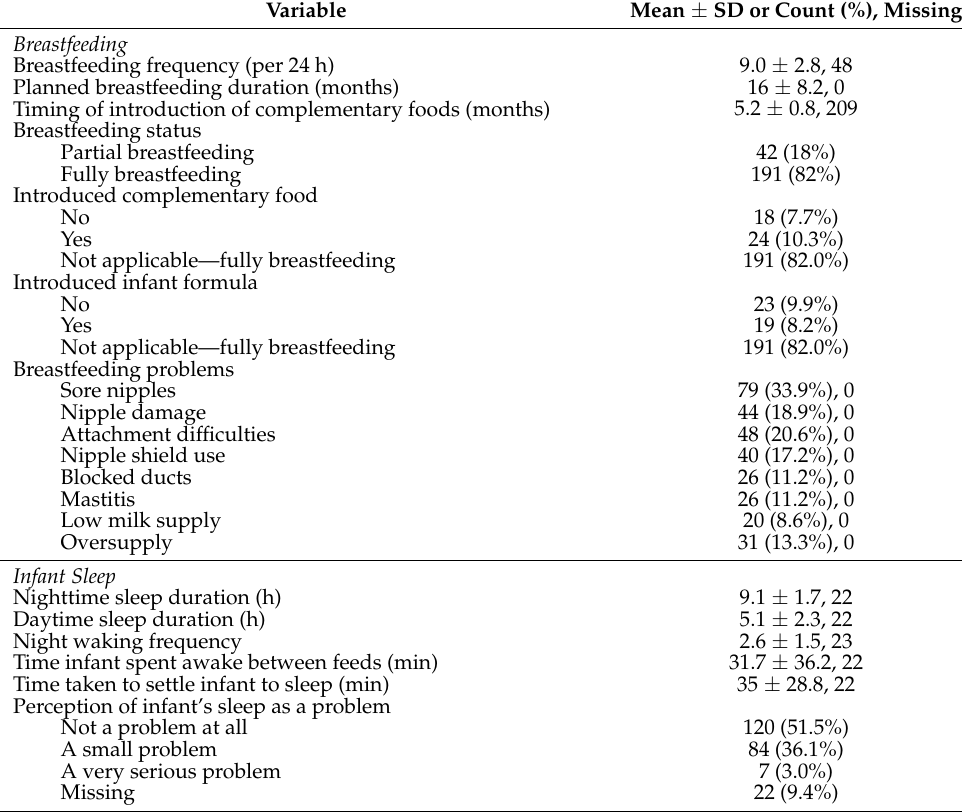
Table 2. Breastfeeding and infant sleep